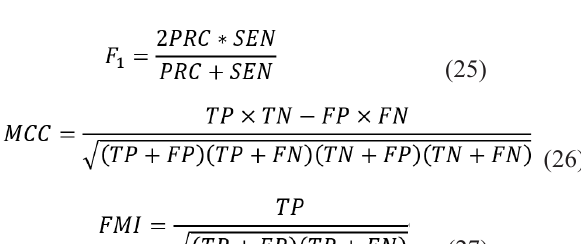
Figure 7. Error bar of average pooling results.